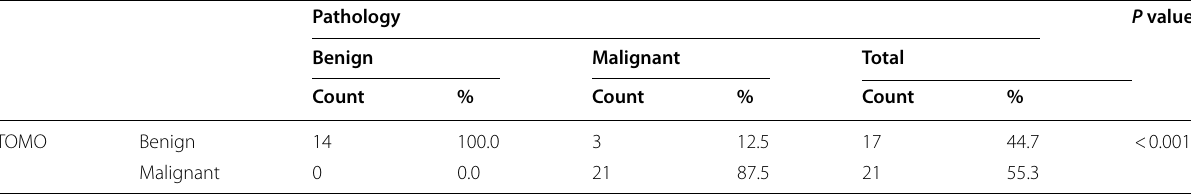
Table 4 Correlation between pathology results and tomosynthesis final results Pathology